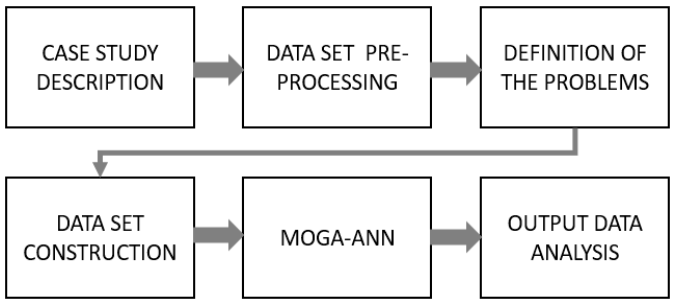
Figure 1. Methodology